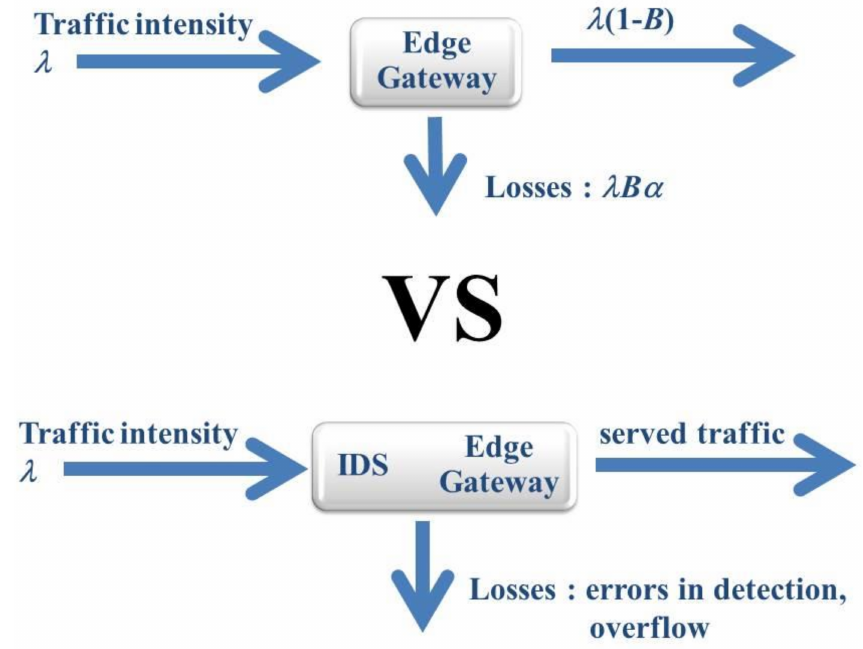
Figure 2. Detailing the problem of choosing an IDS